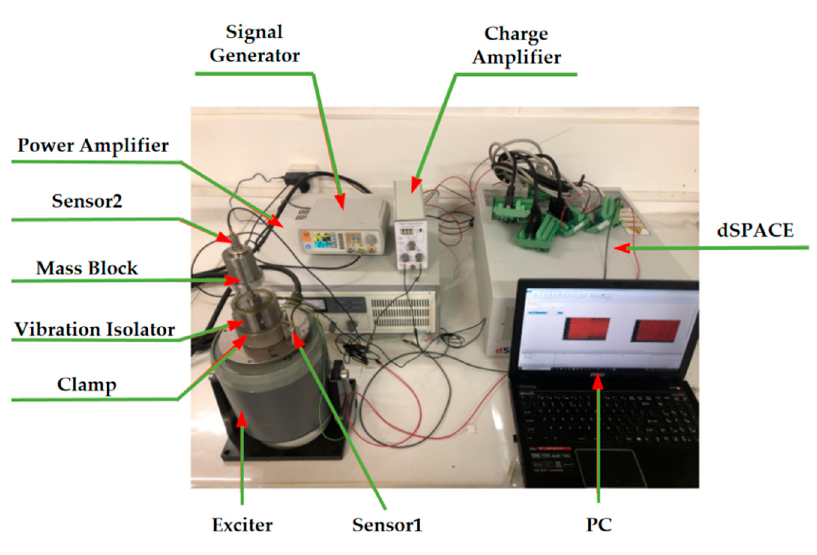
Figure 17. Experimental platform.